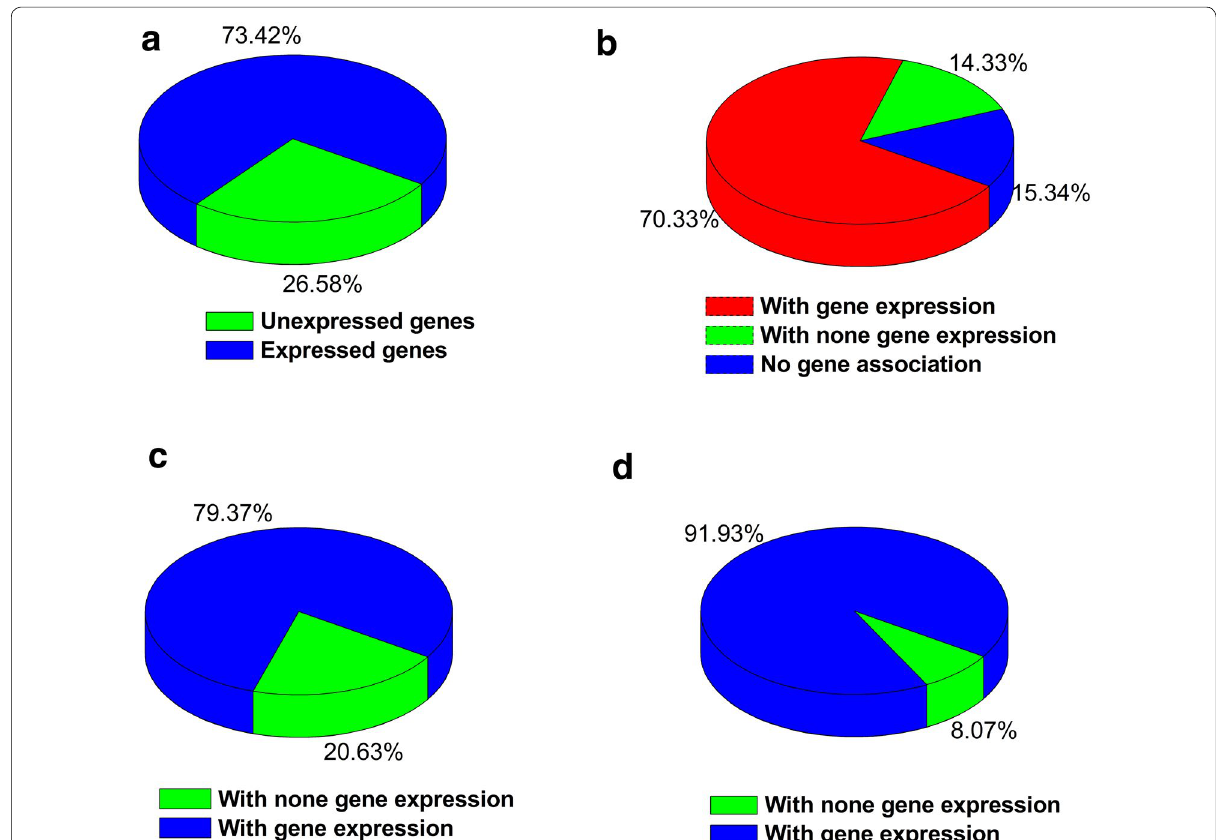
Fig. 2 Verification of iRY1243 by RNA-seq data. Proportions of expressed and unexpressed genes to total genes involved in iRY1243 ( a ), proportion of verified reactions, unverified reactions, and no-gene annotation reactions in remained 1784 reactions (removing the exchange and transport reactions) ( b ), proportion of single-gene reactions with and without gene expression ( c ), and proportion of multi-gene reactions with and without gene expression ( d